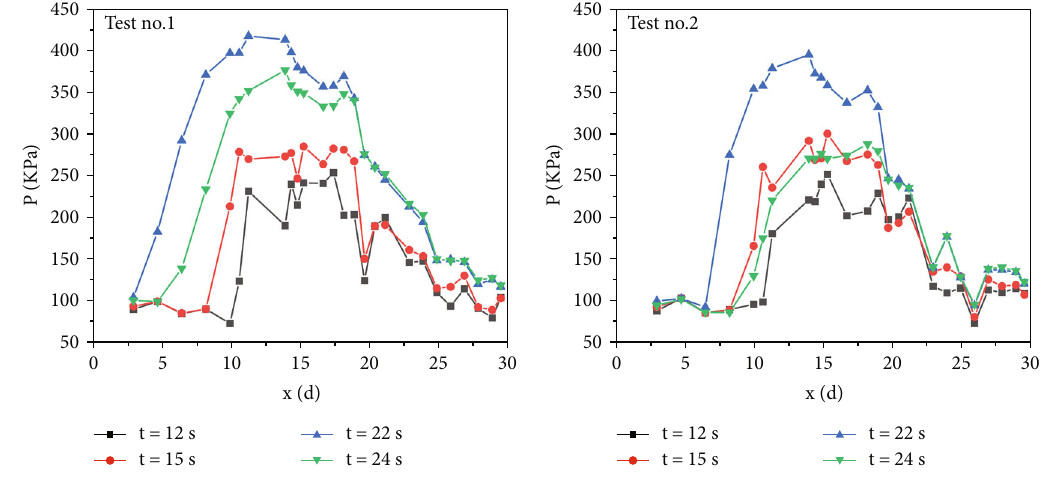
Figure 13: The wall pressure at di ff erent